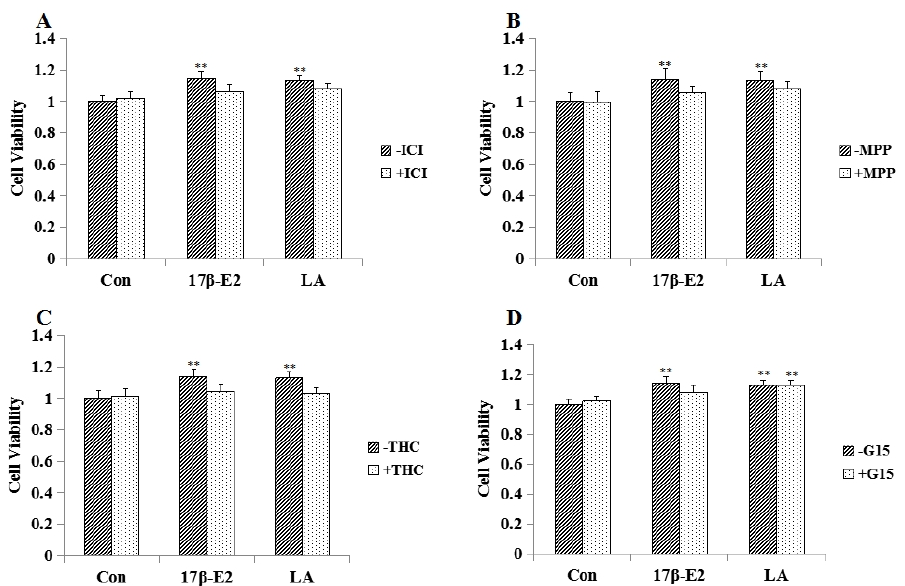
Figure 3. Effect of estrogen receptor antagonists on LA aroused MCF-7 cell proliferation ( n = 3). ( A ) Effects of unspecific ER antagonist (ICI182780) on LA stimulated MCF-7 cell proliferation. ( B ) Effects of methylpiperidino-pyrazole (MPP) on LA stimulated MCF-7 cell proliferation. ( C ) Effects of Delta (9)-tetrahydrocannabinol (THC) on LA stimulated MCF-7 cell proliferation. ( D ) Effects of specific GPR30 antagonist G-15 (G-15) on LA stimulated MCF-7 cell proliferation. * p < 0.05; ** p < 0.01 compared to controls.